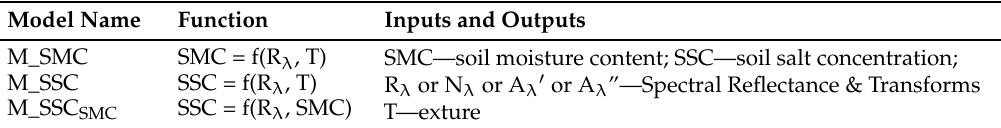
Table 2. Hyperspectral inversion models of soil moisture content and salt concentration.